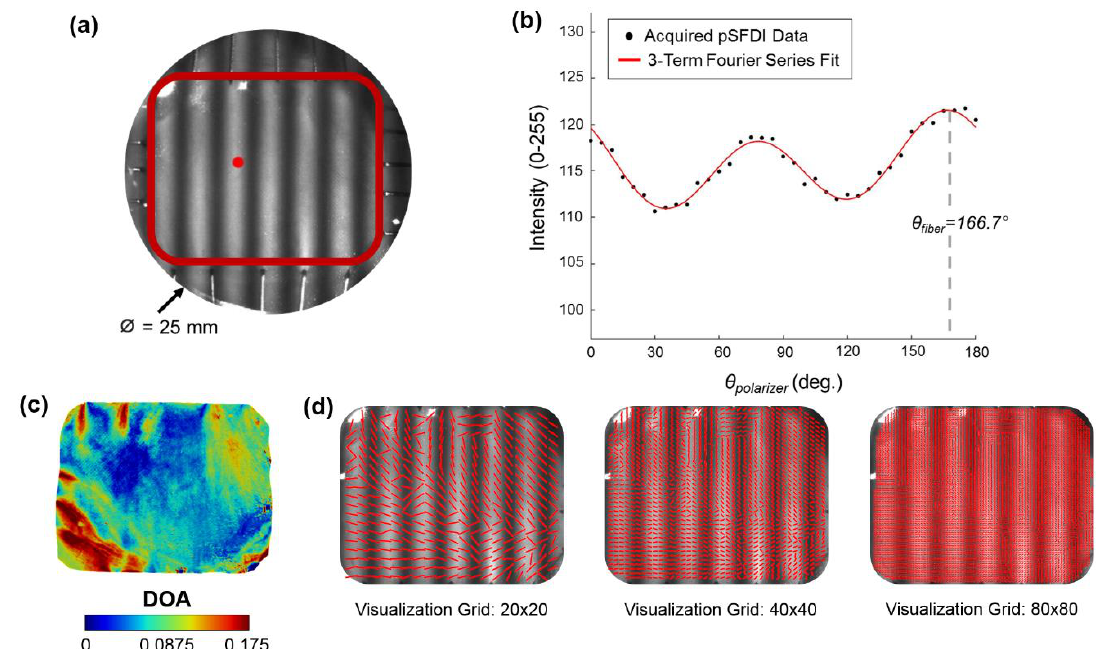
Figure A1. Demonstration of the pSFDI modality to capture the CFA: ( a ) an experimental photo of a representative TV leaflet specimen mounted to the BioTester system, with a defined region of interest as delimited by the red box, and ( b ) the quantified intensity- θ polarizer relationship of a selected pixel point (see the red dot in ( a )), together with the fitting of the 3-term Fourier series in Equation (A2) to the acquired data for predicting the collagen fiber orientation angle θ fiber . ( c ) The quantified DOA throughout the ROI, and ( d ) vector plots of the quantified θ fiber with an increasing level of visualization grid.